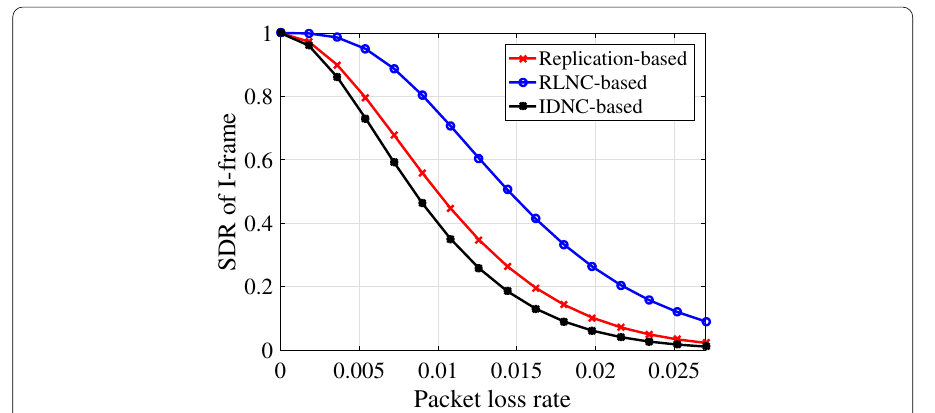
Fig. 4 The impact of loss rate on the SDR of I-frame